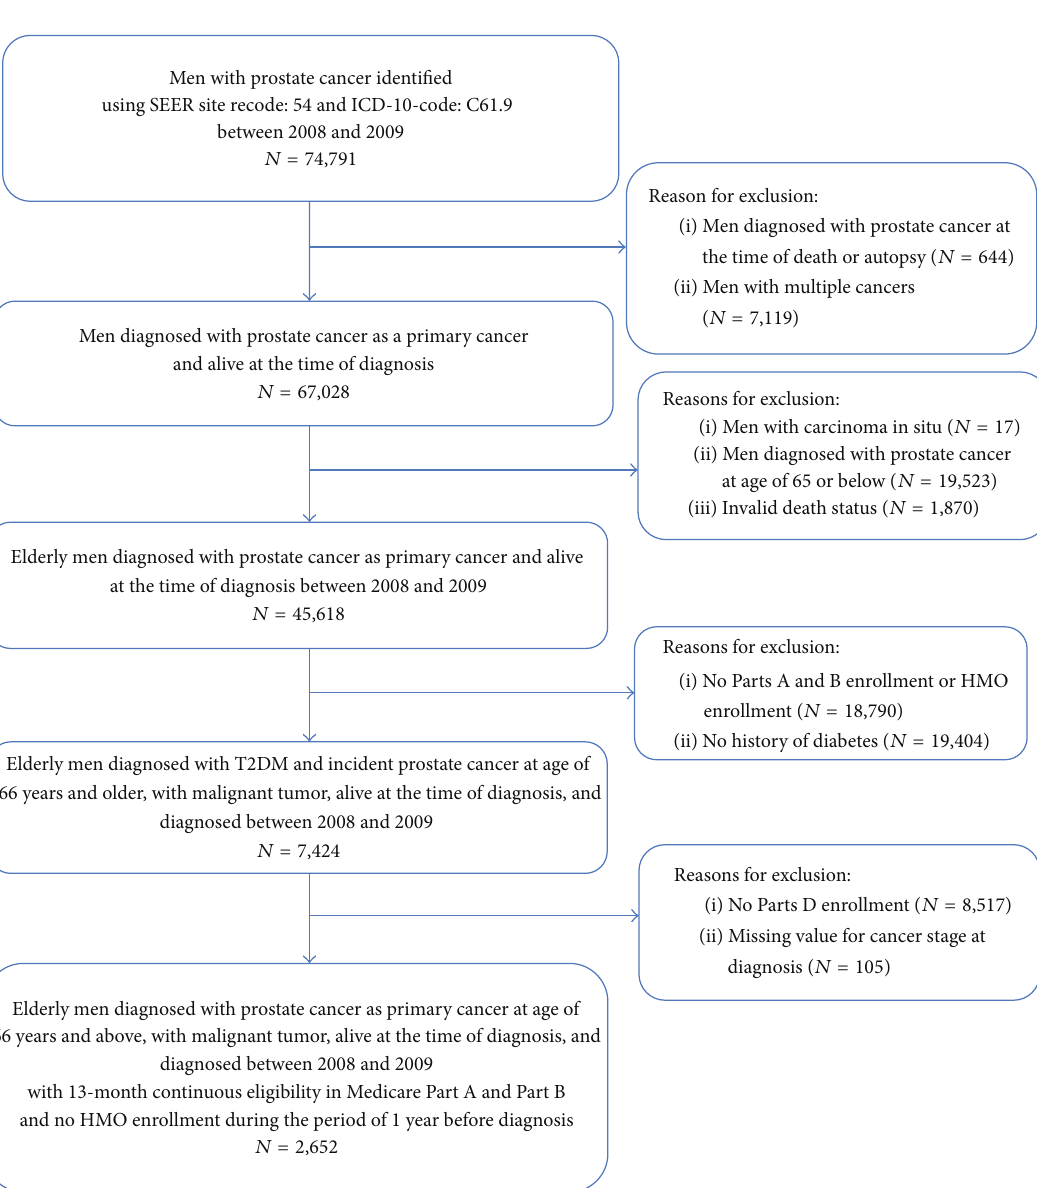
Figure 2: Study cohort development flow diagram for study population of elderly Medicare beneficiaries diagnosed with prostate cancer and